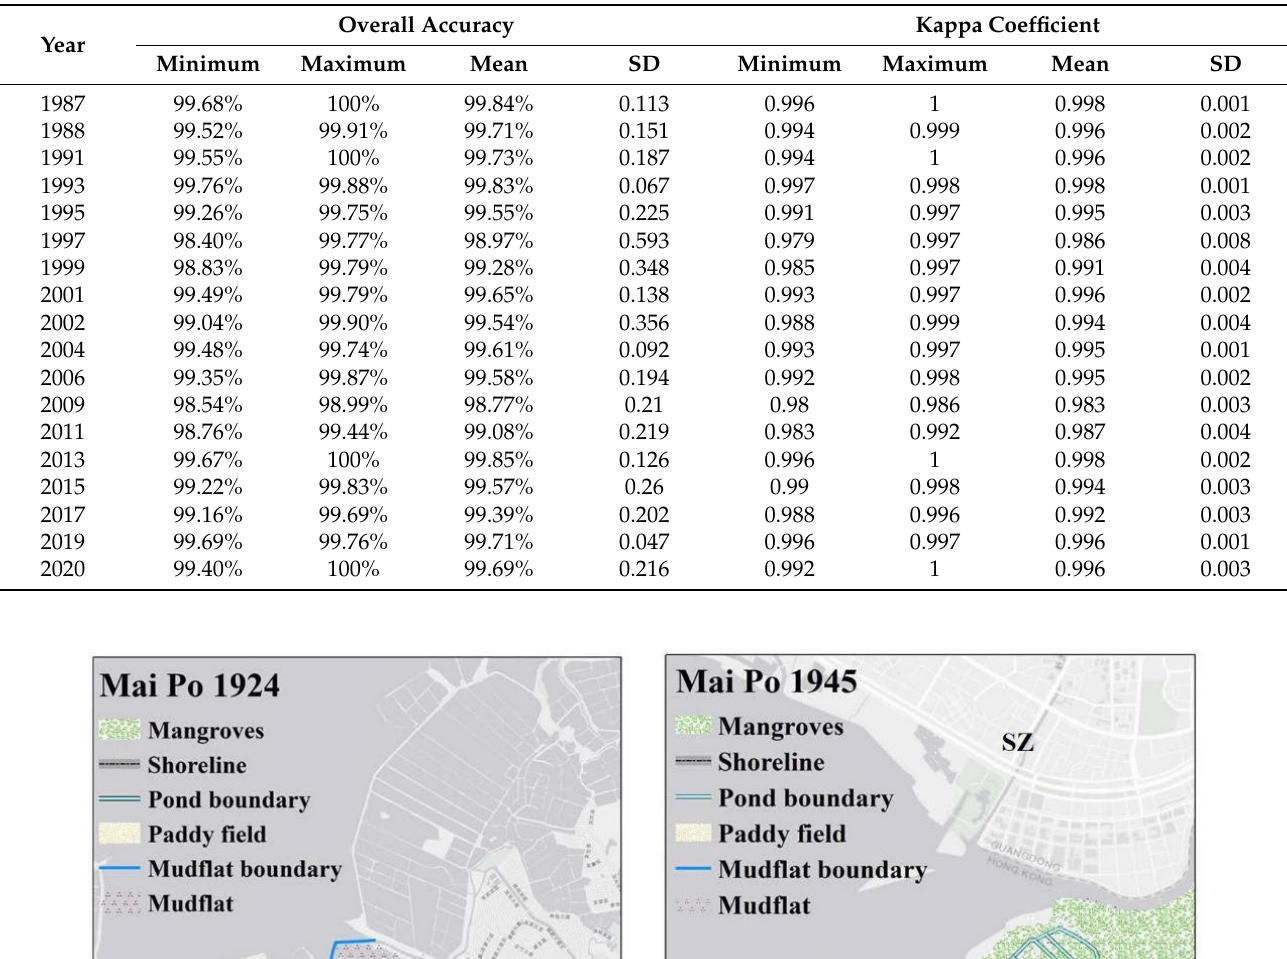
Table 5. Results of five-fold cross validation (SD: Standard deviation).